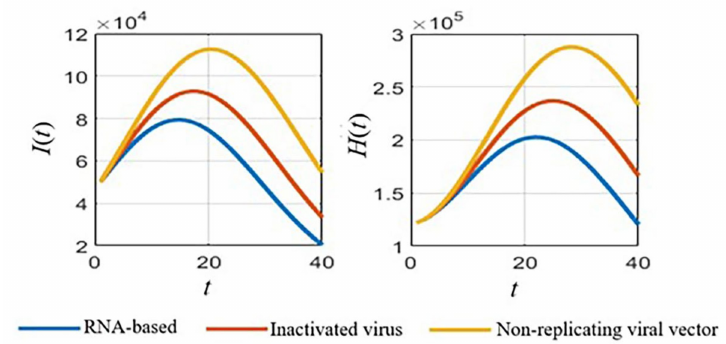
Figure 3. Simulated results for different vaccine types of the SVIHR